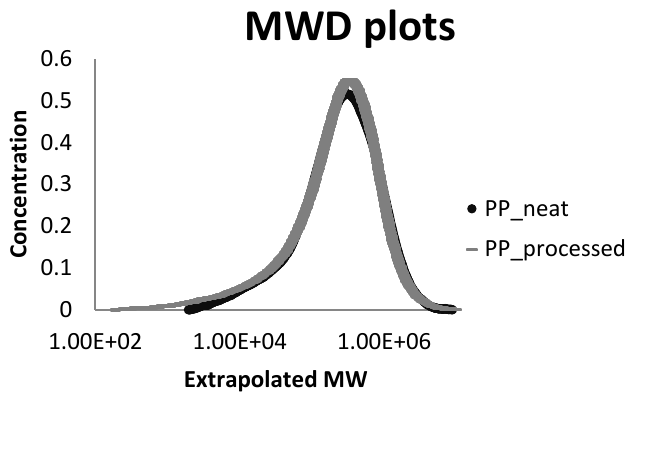
Figure 1. Molecular weight distribution curves as obtained from GPC measurements for the PP